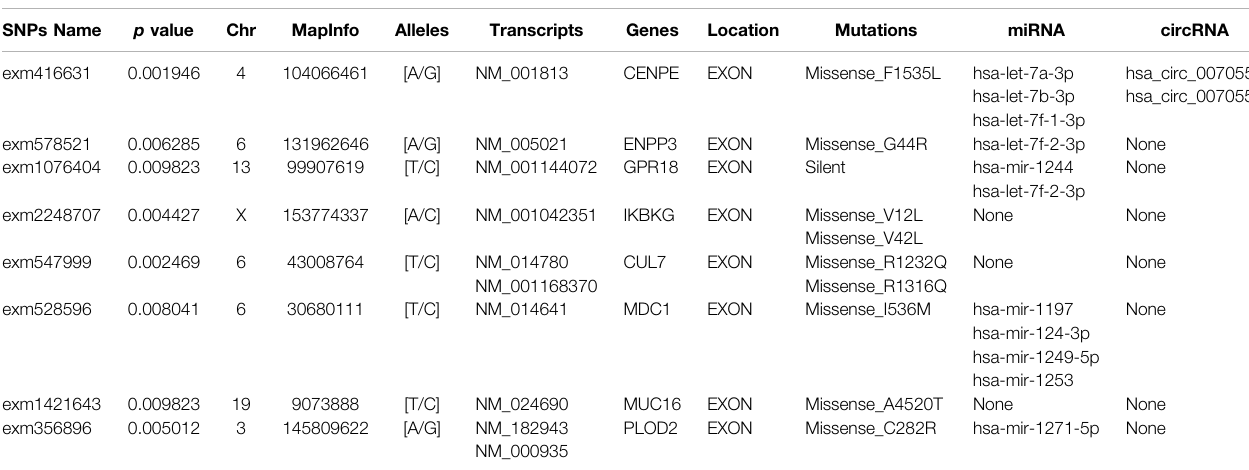
TABLE 2 | The basic information of hub genes of